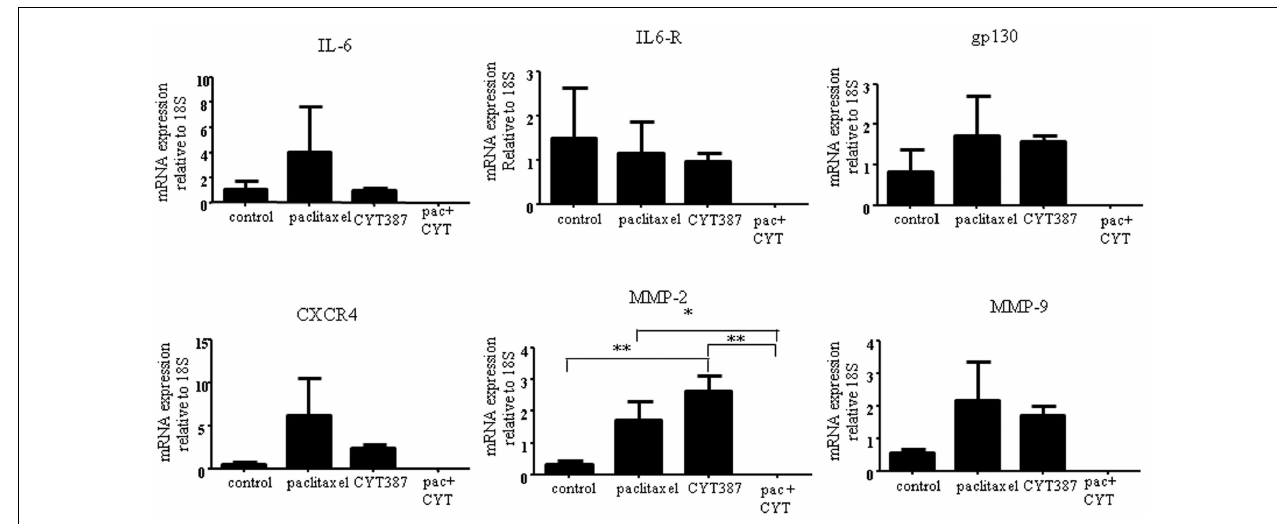
FIGURE 8 |The mRNA expression of IL-6, IL-6R, gp130, CXCR4, MMP-2, and MMP-9 in xenografts generated from subcutaneous transplantation of HEY cells into mice administered with or without paclitaxel, CYT387, or pac + CYT . mRNA from xenografts generated from the control group and treatment groups was extracted, cDNA was prepared, and q-PCR for